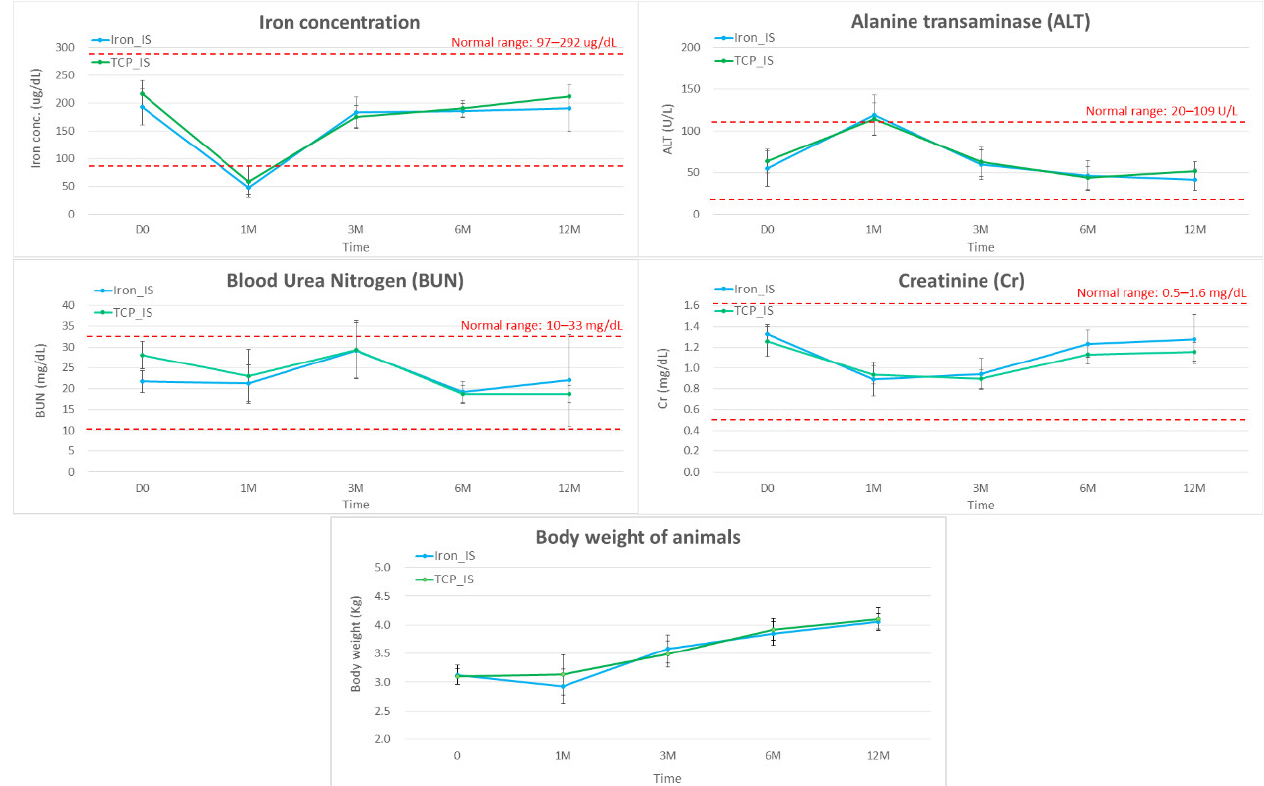
Figure 6. Changes in blood iron (µg/dL), alanine transaminase (ALT, U/L), blood urea nitrogen (BUN, mg/dL), and creatinine (Cr, mg/dL) concentrations and body weights of animals (kg) in months 0, 1, 3, 6, and 12 after implantation. Error bars represent standard deviations, and red dotted lines denote upper and lower limits.